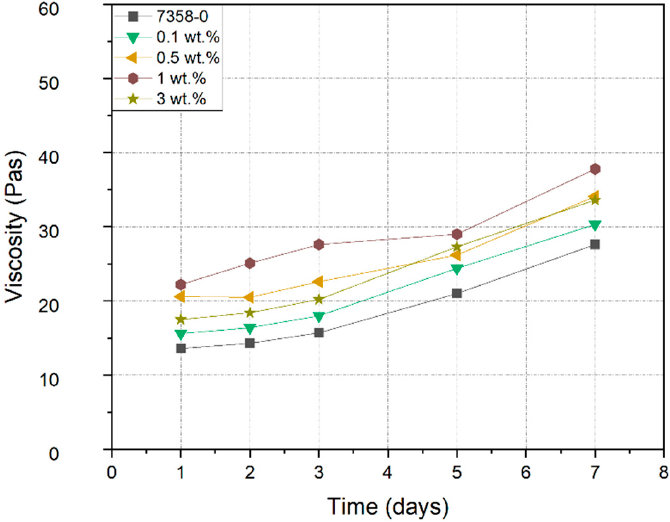
Figure 5. Influence of palygorskite-0.5MPTMS addition on Si-PSA composition viscosity.